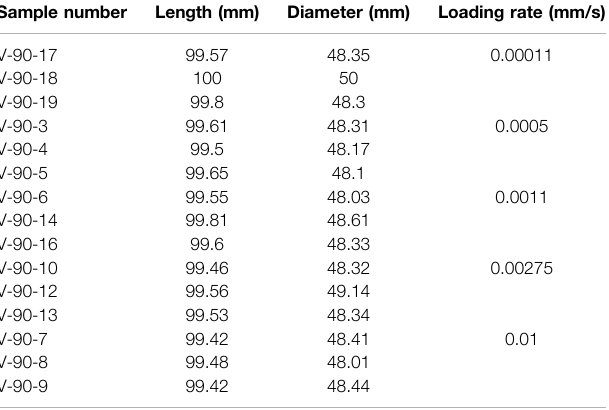
TABLE 1 | Sample information and loading conditions.